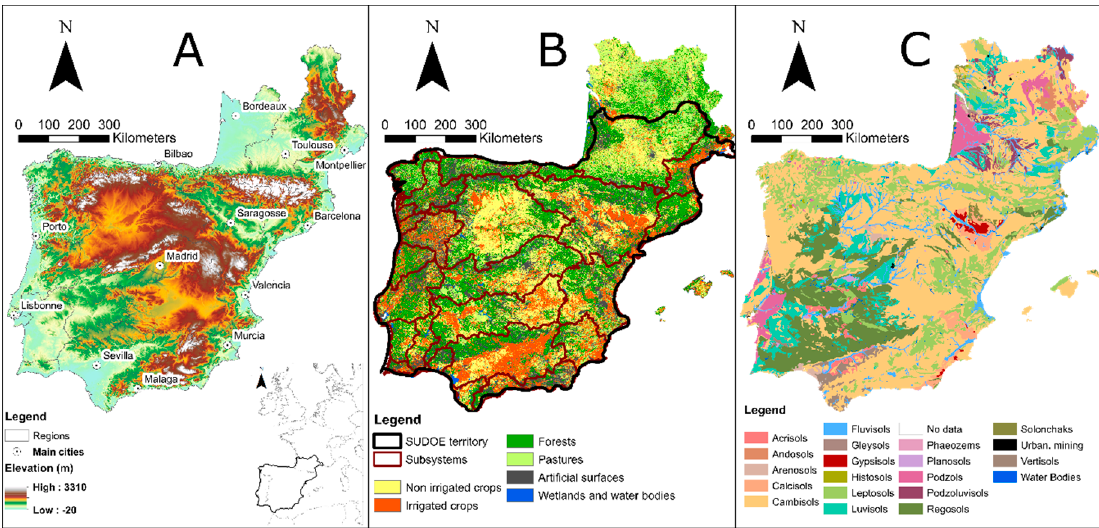
Figure 1. SUDOE study area characteristics ( A ) Topography, main cities and regions; ( B ) Land use and subsystems; ( C ) Pedology.